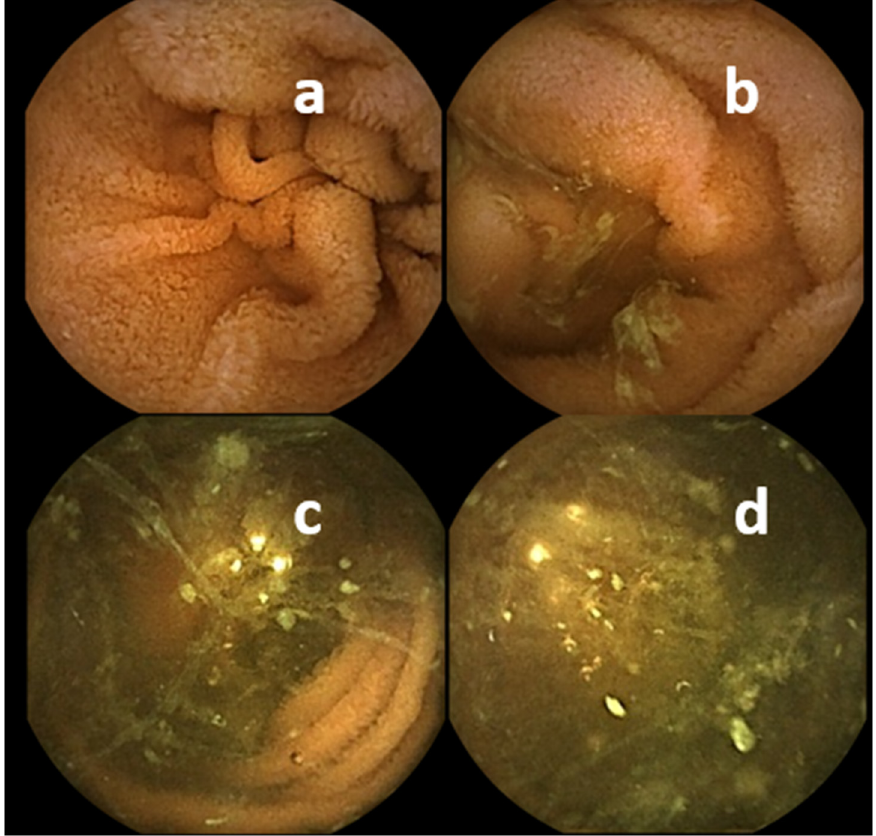
Figure 2. Mucosa visualization in SBCE: ( a ) perfect, ( b ) good, ( c ) fair, ( d ) poor.